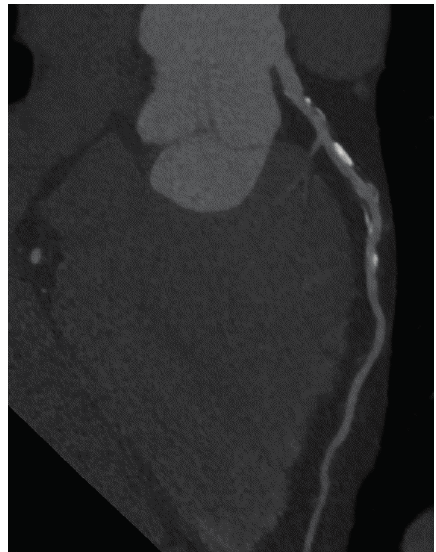
Figure 5. Calcified and noncalcified plaques in LAD.